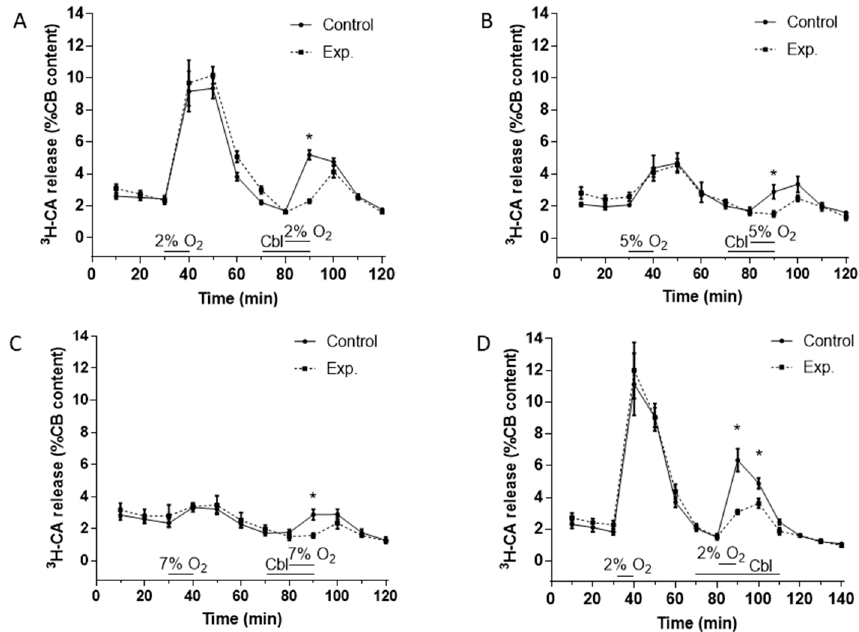
Figure 2. Effects of Cbl on 3 H-CA release response elicited by different levels of hypoxia. The continuous lines in ( A ), ( B ), and ( C ) show the effects on catecholamine release of successive exposures of CBs (at 40–50 min, SI, and 80–90 min, SII) to 2% O 2 ( A , n = 12 in each group), 5% O 2 ( B , n = 5 in each group), and 7% O 2 ( C , n = 5 in each group) under control conditions, whereas the dashed lines illustrate catecholamine release evoked by a similar protocol when 300 µ M Cbl was present between 70 and 90 min. ( D ). Protocol similar to panels A except that Cbl was present both during and after the second hypoxic challenge (from 70 to 110 min), n = 8 and 12, control and experimental group, respectively. Asterisks connote time points where there were significant differences between the amplitudes of 3 H-CA release observed in CBs which were exposed or not exposed to